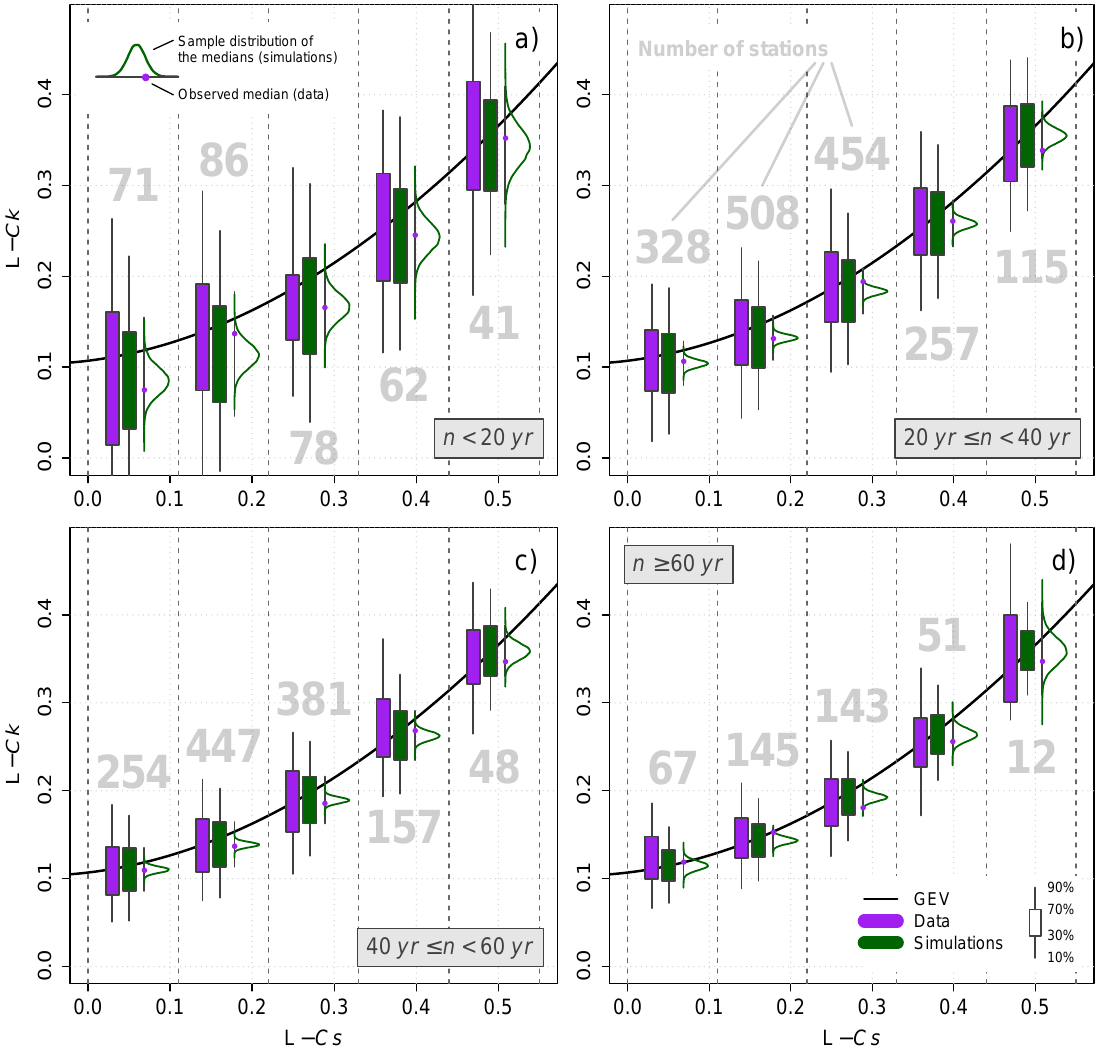
Figure 3. Monte Carlo simulations comparing the distribution of sample L-Ck from 50000 realisations at the European scale, all randomly drawn from GEV distributions (green box plots) and the distribution of sample L-Ck from the FloodFreq database (purple box plots). Results are sorted by station sample length n in (a) n < 20yr, (b) 20yr ≤ n < 40yr, (c) 40yr ≤ n < 60yr, and (d) n ≥